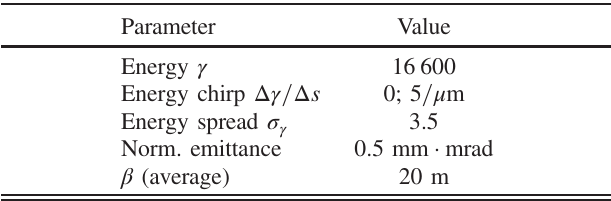
TABLE II. Electron beam parameters.